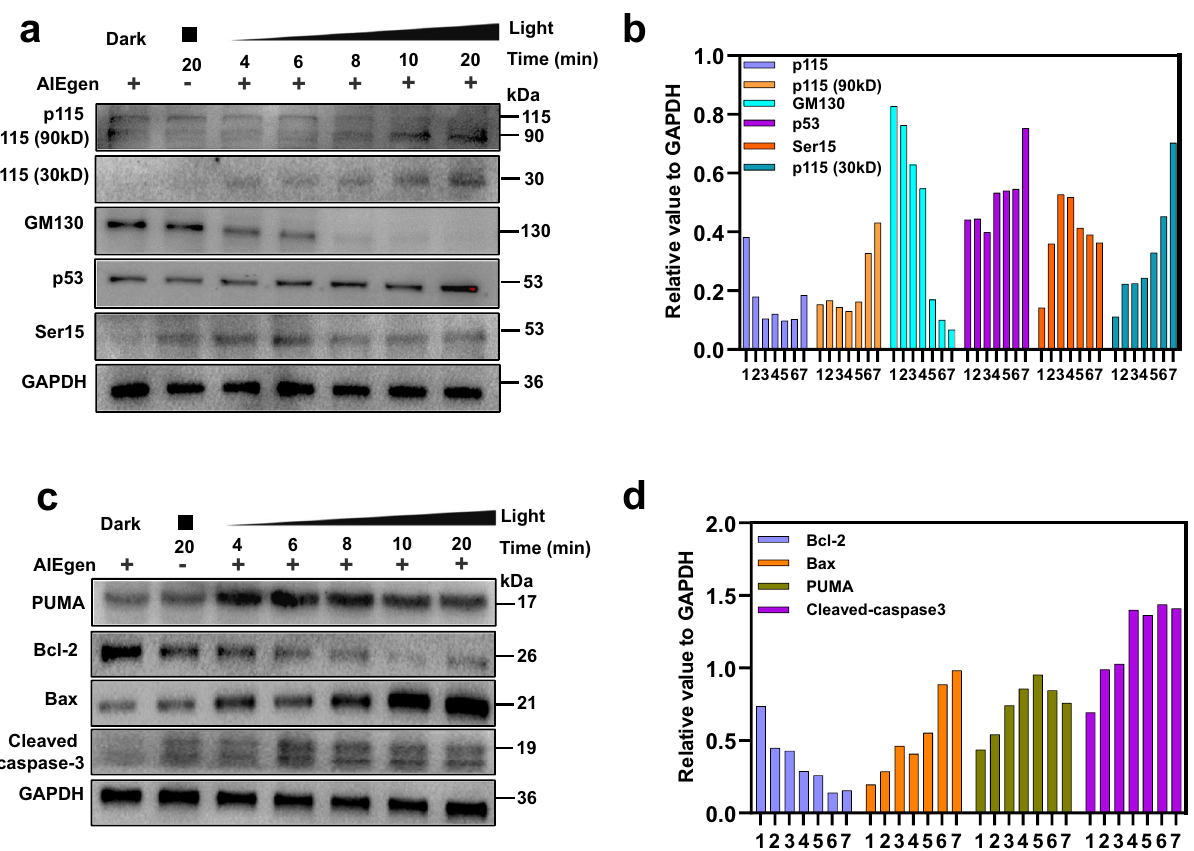
Fig. 7 Golgi apparatus and mitochondria associated protein expression after PDT. The expressions of p115, p115 (90 kD), p115 (30kD), GM130, p53, ser15 in Golgi apparatus ( a ) and PUMA, Bcl-2, Bax, caspase-3 in mitochondria ( c ) after different treatment with TPE-PyT-CPS (0.2 μ M) under light irradiation (25 mWcm − 2 ). ( b ) and ( d ) western blot statistical chart of the relative expression levels of protein expressions in different treating groups (1. dark; 2. only light, 20 min; 3-7: with light and TPE-PyT-CPS for 4, 6, 8, 10 and 20 min, respectively) by imageJ and the value of protein expression is relative to GADPH. The experiments were performed two times independently with similar results, representative images are shown. Source data are provided as a Source Data fi